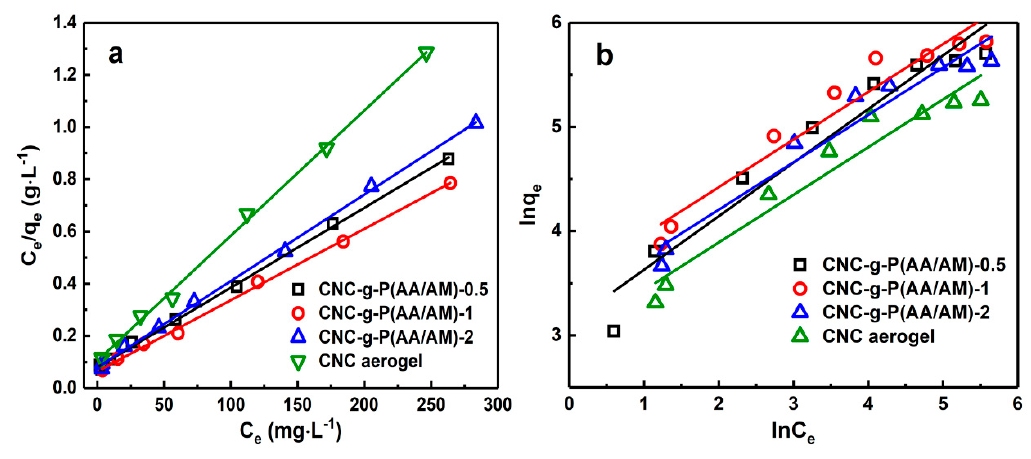
Figure 6. Comparison of the adsorption isotherm models for Pb(II) adsorption on the CNC-g-P(AA / AM)-0.5, CNC-g-P(AA / AM)-1, CNC-g-P(AA / AM)-2, and CNC aerogels. The ( a ) Langmuir and ( b ) Freundlich models.